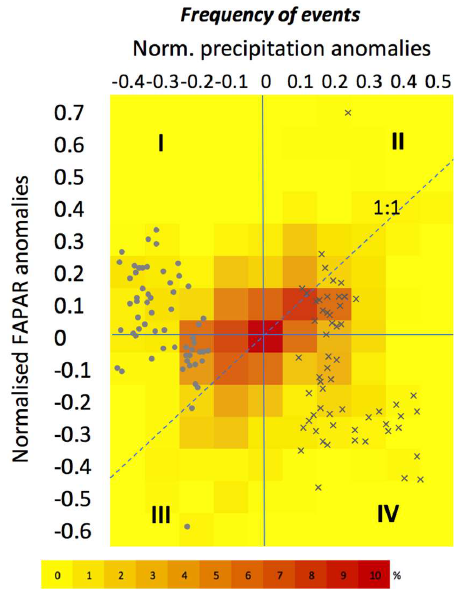
Figure 5. Anomalies of the yearly cumulated FAPAR vs rainfall. The anomalies of each of the 900 observed events (60 sites by 15 years), are normalized by their respective long-term site mean values and binned in categories of 0.1 (i.e., 10%). The color scale represents the frequency of events occurring within each category, with yellow being low frequency and red being high frequency. The dots represent the values for 2011 and the crosses the values for 2009. Remote Sens. 2018 , 10 , x FOR PEER REVIEW